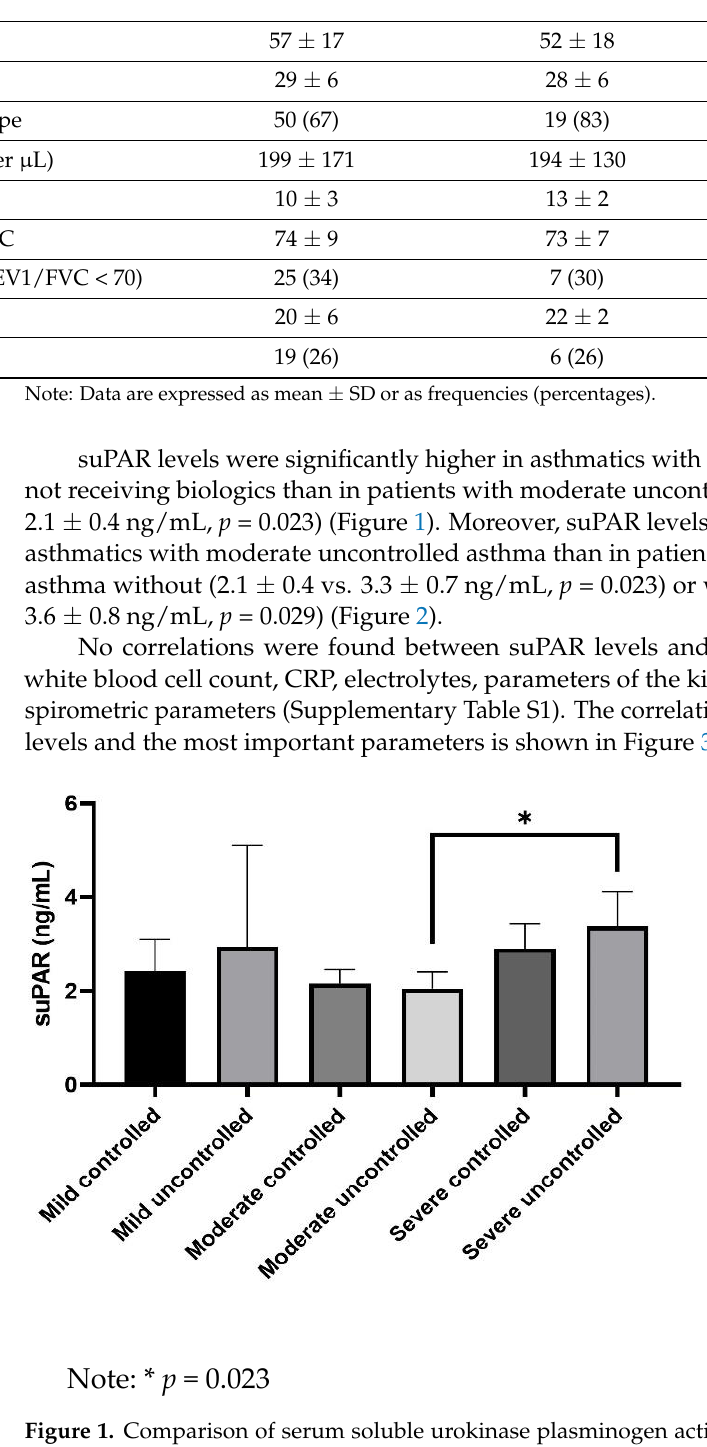
Table 1. Demographic, clinical and spirometric characteristics of the asthmatics ( n = 74).